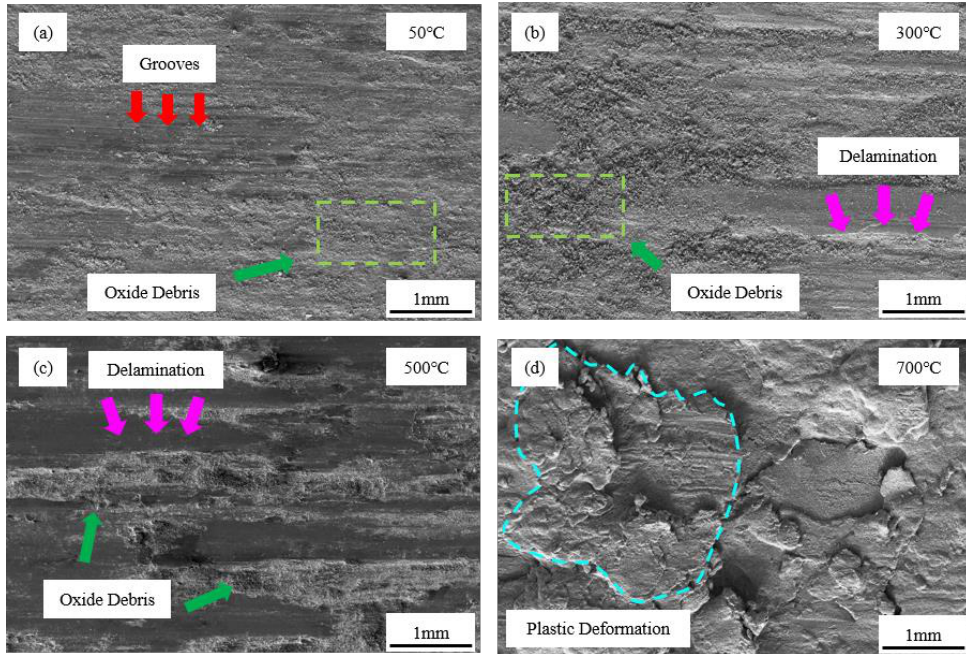
Figure 8. Worn surface morphologies of FeCrSiNiCoC coating at ( a ) 50 °C, ( b ) 300 °C, ( c ) 500 °C, and ( d ) 700 °C.